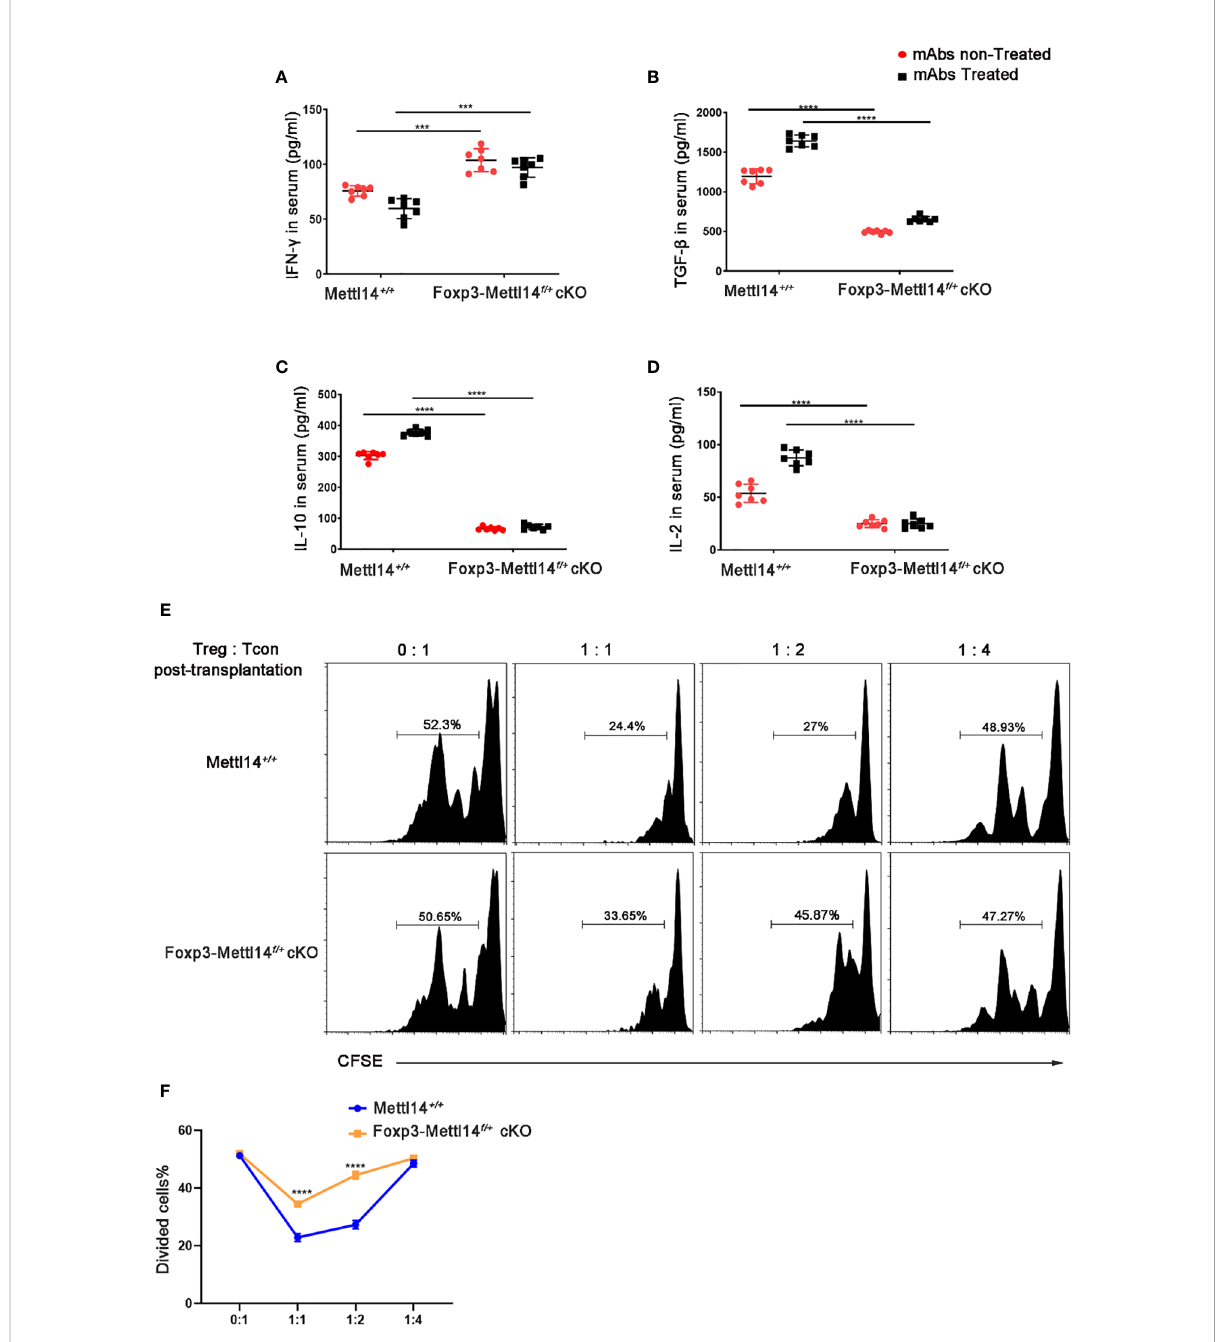
FIGURE 4 METTL14 de fi ciency Treg cells resulted in the loss of suppressive function after transplantation. (A – D) Serum was collected on day 7 after transplantation and cytokine levels were measured using ELISA assay. In the presence or absence of mAbs treatment, the scatter plots show the mean serum cytokine concentration in picograms per milliliter of IFN- g (A) , TGF- b (B) , IL-10 (C) and IL-2 (D) from serum in Foxp3-Mettl14f/+ cKO mice and littermate controls (n=7). (E) The islets were isolated from BALB/c mice and transplanted them under the kidney capsule of littermate controls or Foxp3-Mettl14f/+ cKO mice with STZ-induced diabetes. These mice were treated with mAbs as described above. Treg cells were isolated on day 7 post-transplantation which were co-cultured with CFSE-labeled CD4+ naïve T cells from C57BL/6J mice, in round- bottom 96-well plates containing anti-CD3 (3 m g/ml) and anti-CD28 (5 m g/ml) monoclonal antibodies, at various ratios for 5 days. The suppressive effect on T cell expansion was detected using fl ow cytometry. (F) The suppressive function of Treg cells was quanti fi ed. The data are presented as the means ± SD. The data in (A-D) depict the mean values measured from seven separate experiments, while the data in (D) are representative of at least three independent experiments. The statistical analysis was performed with an unpaired Student ’ s t-test (two- tailed). ****P<0.0001 and